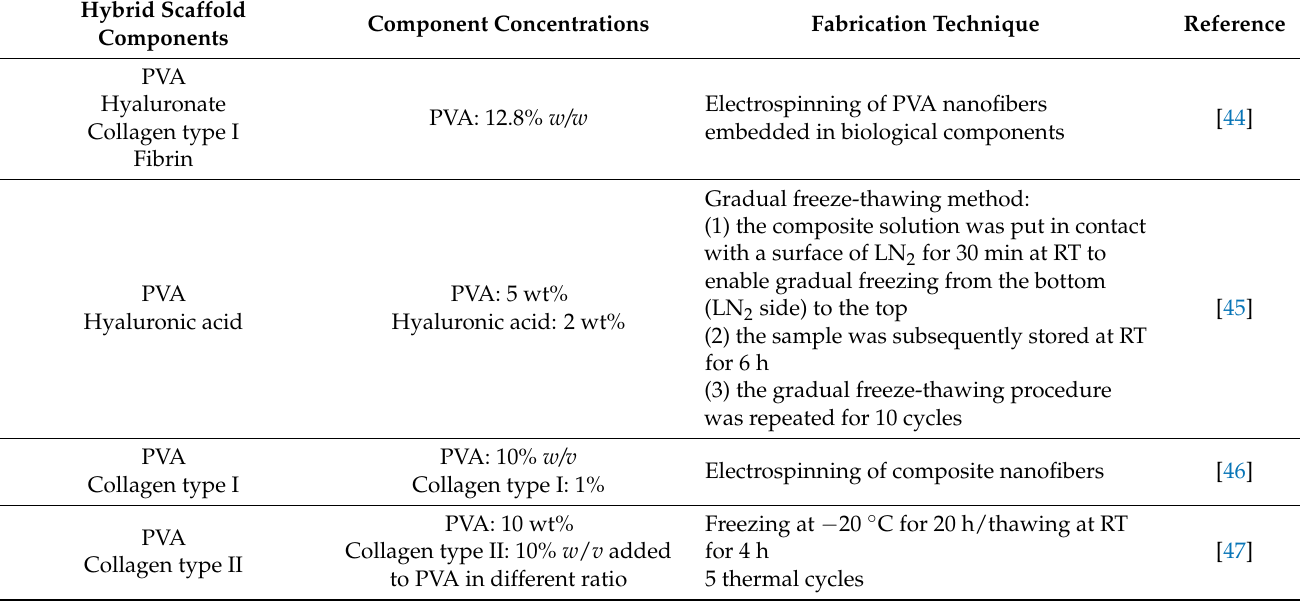
Table 1. Composition and fabrication methods of PVA/natural materials blends for cartilage TE. Hybrid Scaffold Component Concentrations Fabrication Technique Components